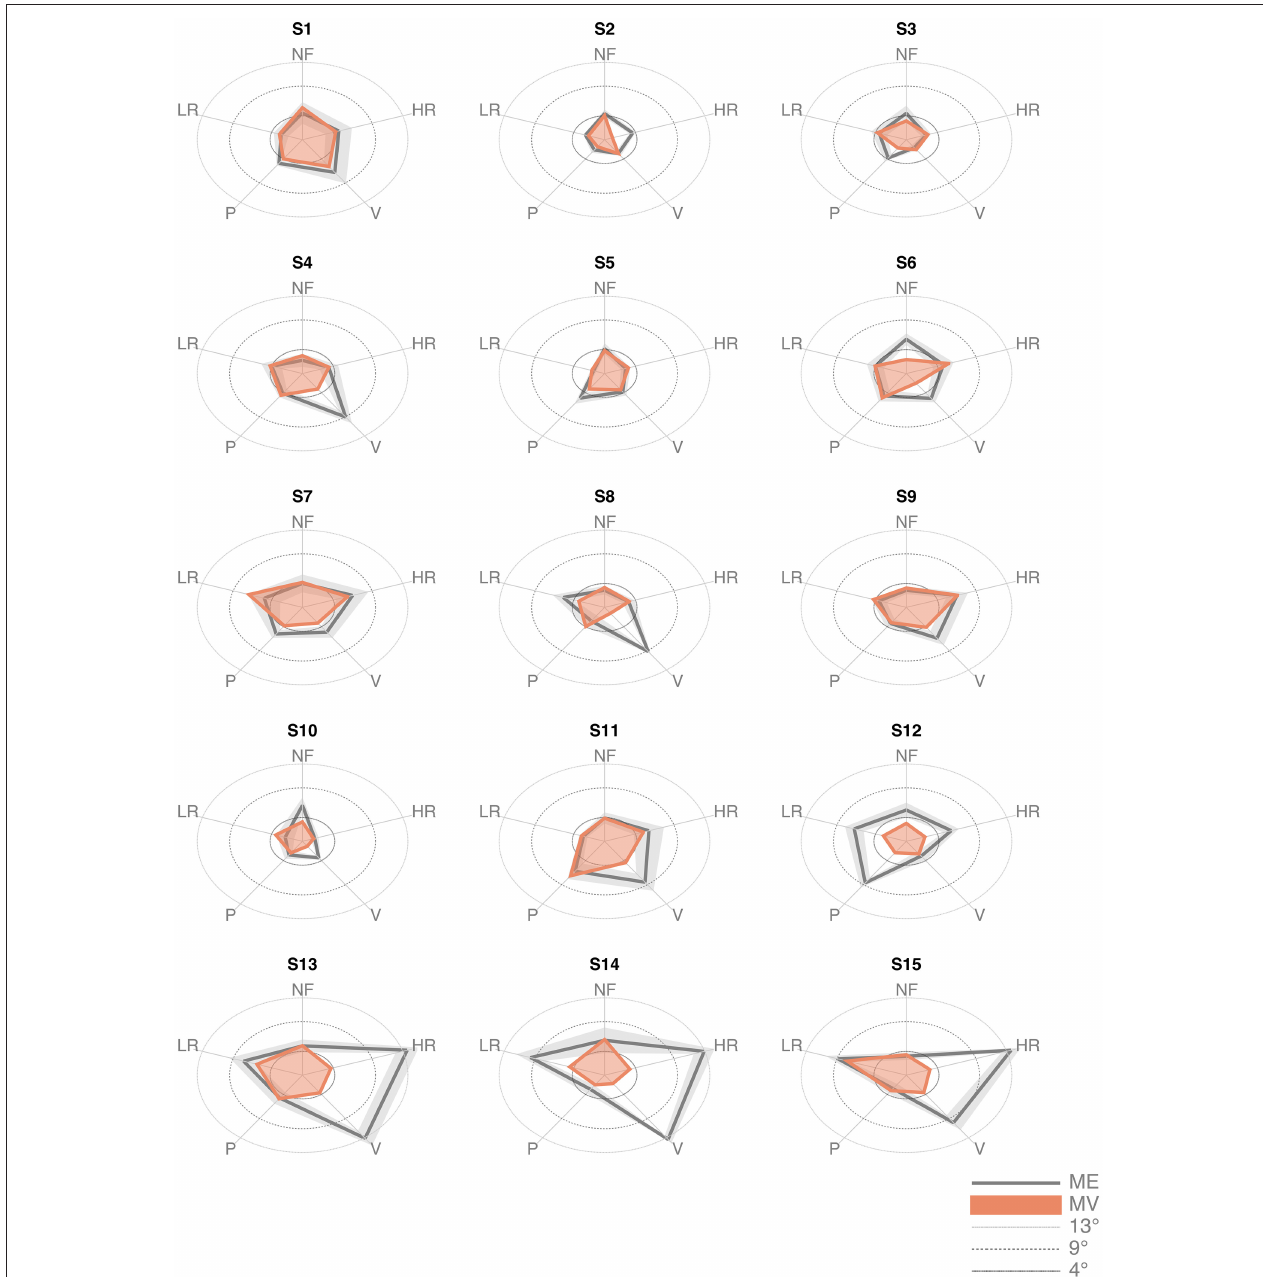
FIGURE 4 | Matching error (Mean and standard deviation across the 6 trials) and Matching Variability (standard deviation of the matched position across the 6 trials) of the 15 subjects, in the five force conditions.